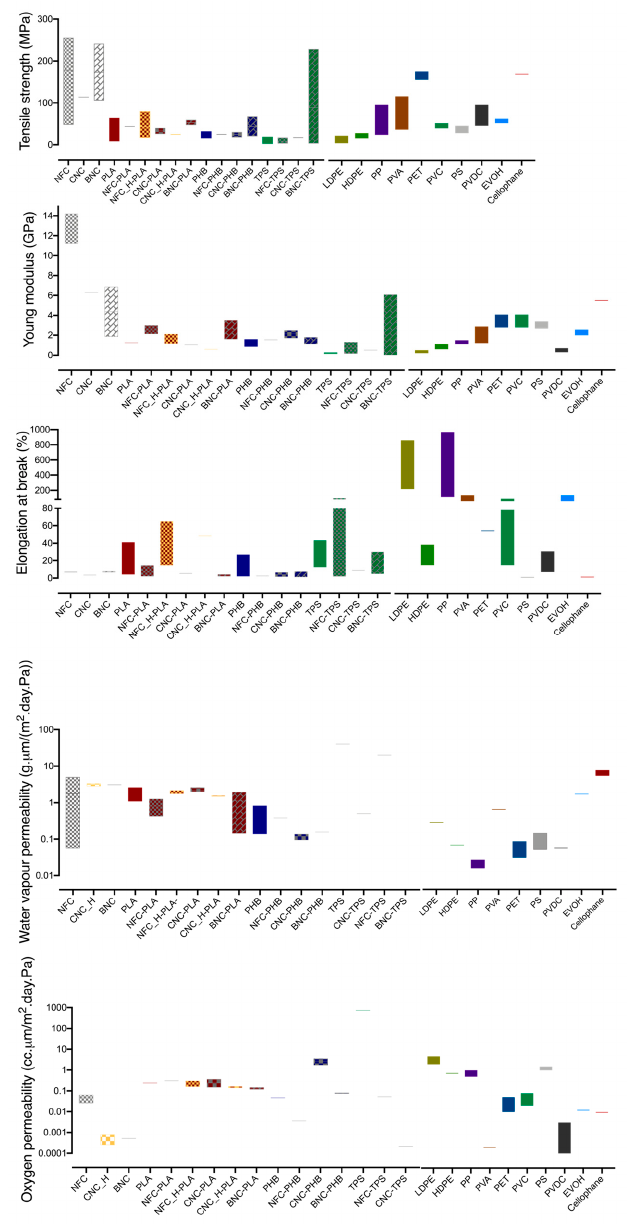
Figure 2. Mechanical and barrier properties of nanocellulosic based composites and petroleum-based plastics [34,35,37,41,58–60,62,65–81]. PET—Polyethylene Terephthalate; PP-Polypropylene; Low density polyethylene; HDPE-High density polyethylene; PS-Polystyrene; PVDC-Polyvinylidene